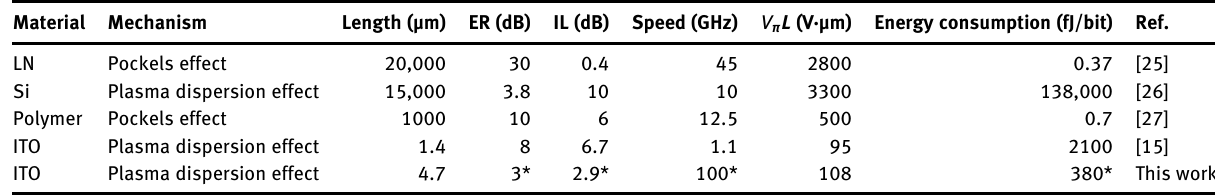
Table  : Figure of merit comparison for different type Mach – Zehnder interferometric modulators. Material